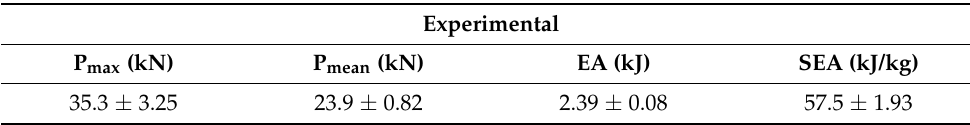
Table 3. Peak force, mean force, and